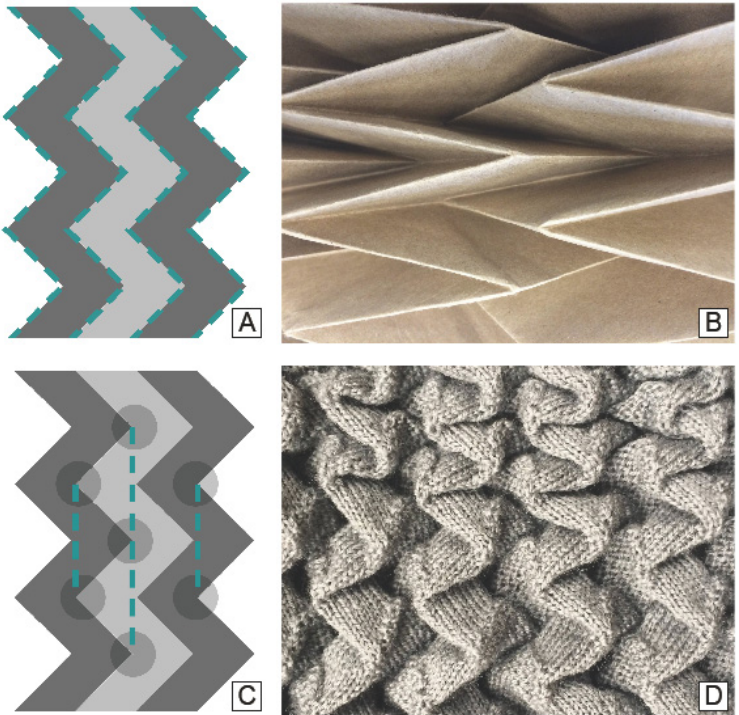
Figure 2. ( A ) Diagram of paper folding lines, represented by dotted lines; ( B ) paper sample; ( C ) diagram of textile folding lines, represented by dotted lines; ( D ) merino wool textile